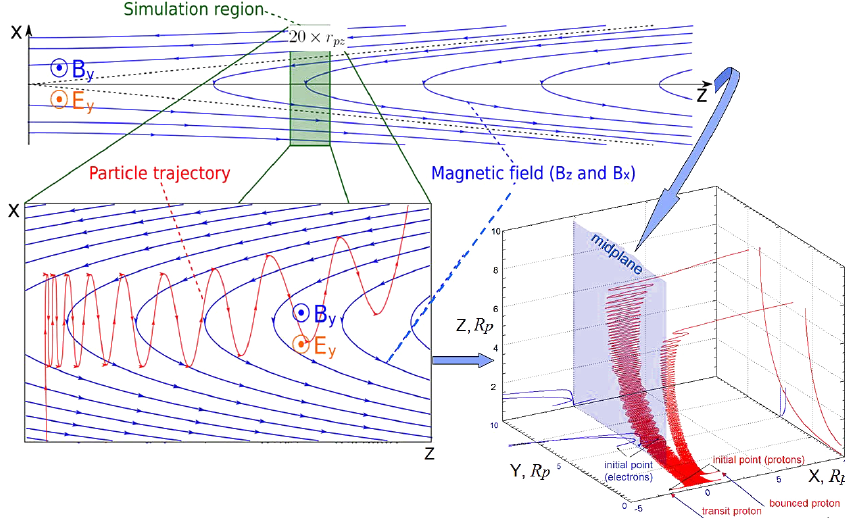
Figure 7. The PIC simulation region (with a close-up at the bottom left) with respect to a whole current sheet (courtesy of Siversky and Zharkova, 2009b). The current sheet simulation plane is the XZ plane; the plane X = 0 is the current sheet midplane (indicated by blue shading in the bottom-right close-up). E y is the electric field brought into a diffusion region by a magnetic field reconnection (a reconnection electric field); B y is a guiding magnetic field component. The boundaries of the rectangle are accepted to be transparent to particle motion and the periodic boundary conditions used (see the text for details). The close-up at the bottom right shows trajectories of transit and bounced protons (red lines) and electrons (blue